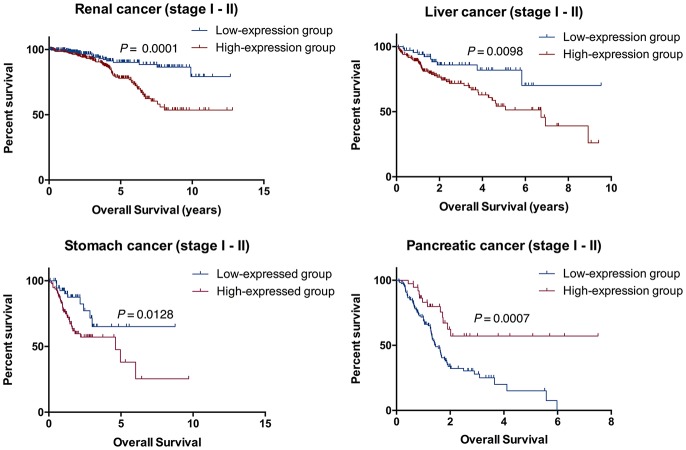
RADIL could be helpful for predicting the survival of patients in stage I and II. AUC calculated with Kaplan-Meier and log-rank methods in the early stage (I and II) patients gave similar results to that of the entire cohort in renal cancer (P = 0.0001), liver cancer (P = 0.0098), stomach cancer (P = 0.0128) and pancreatic cancer (P = 0.0007).